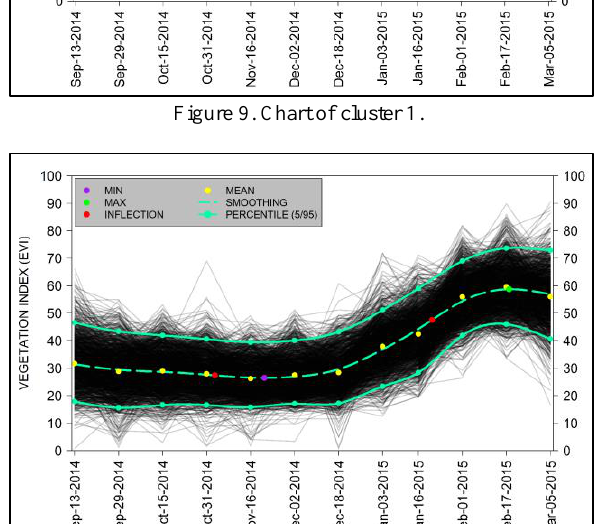
Figure 10. Chart of cluster